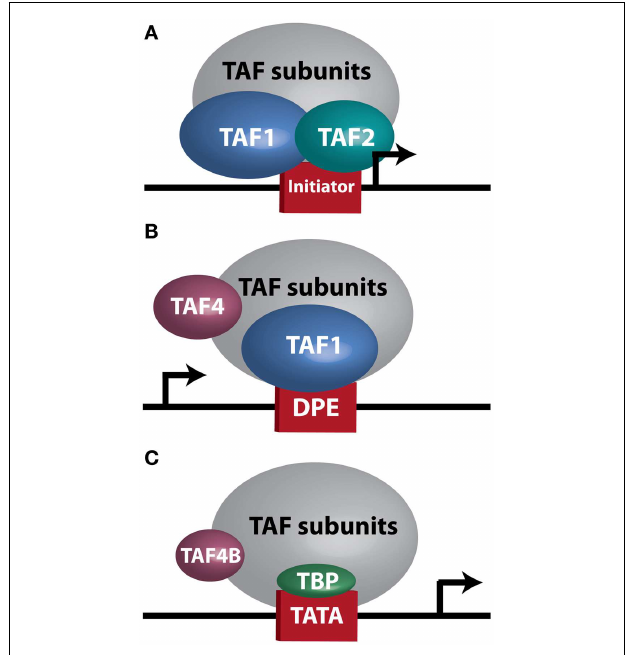
FIGURE 1 |TFIID sub-complexes . Arrows indicate transcription start site. (A) ATAF1/TAF2 complex contacts Initiator at aTATA-less promoter. (B) TAF1 contacts a downstream promoter element (DPE) at aTATA-less promoter.TAF4 is also important for this interaction. (C) TAF4B substitutes forTAF4 in aTFIID complex bound at aTATA-box